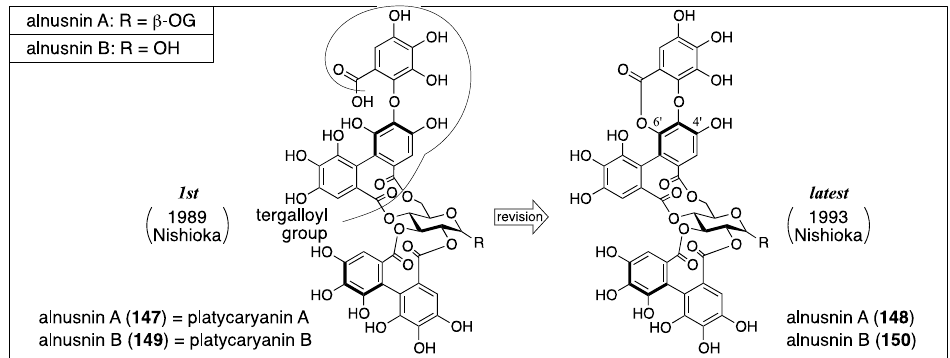
Figure 50. The transition of the structure of alnusnin A and B.